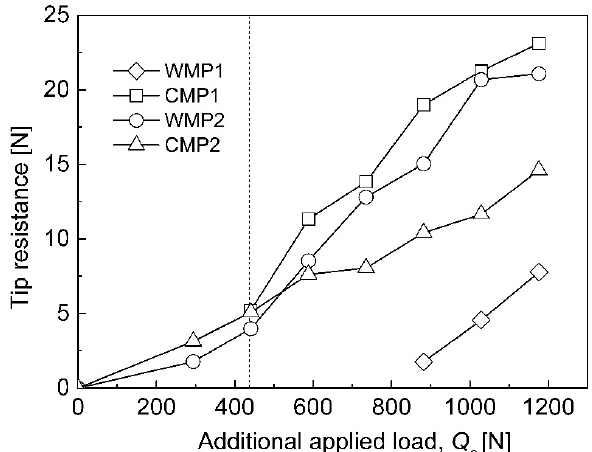
Figure 10. Tip resistance of the underpinning micropiles with respect to the additional load applied to the